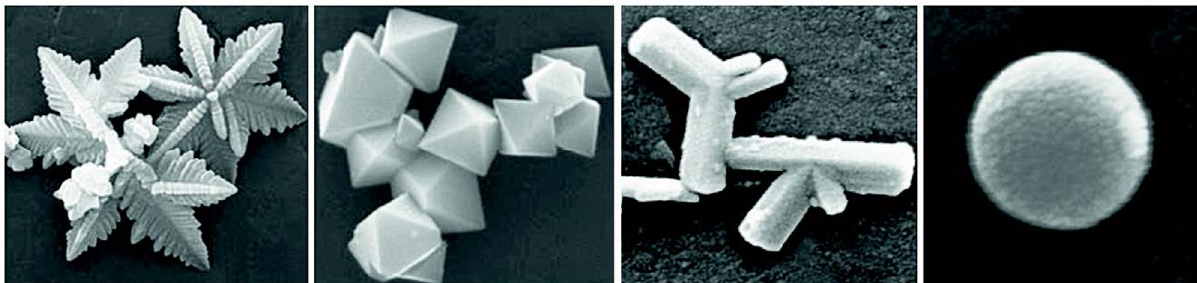
Figure 15: Well - known morphologies of metal oxides [ 10 ]